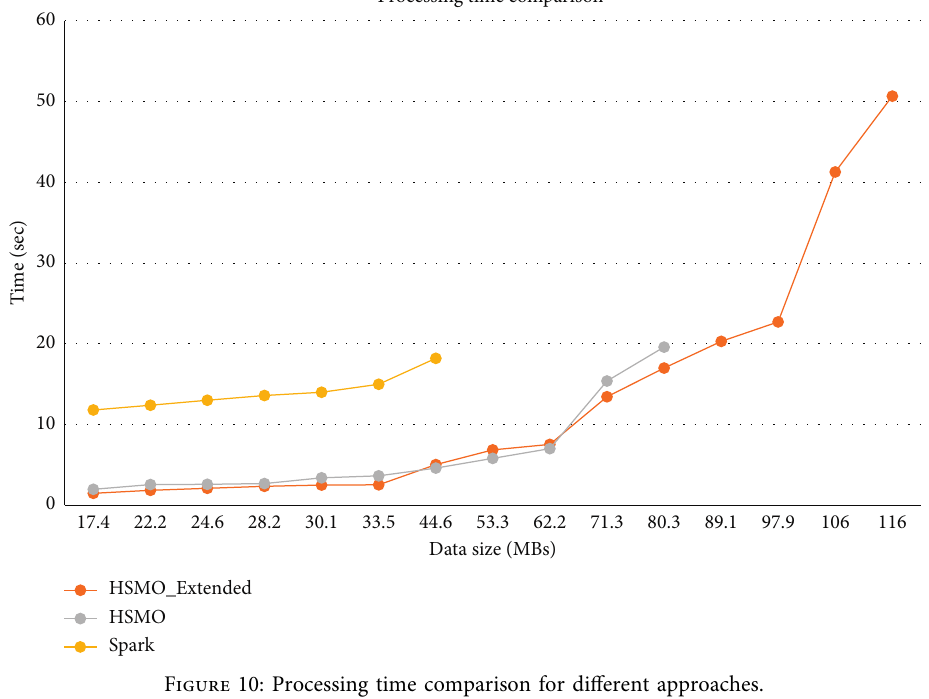
Figure 10: Processing time comparison for different approaches.